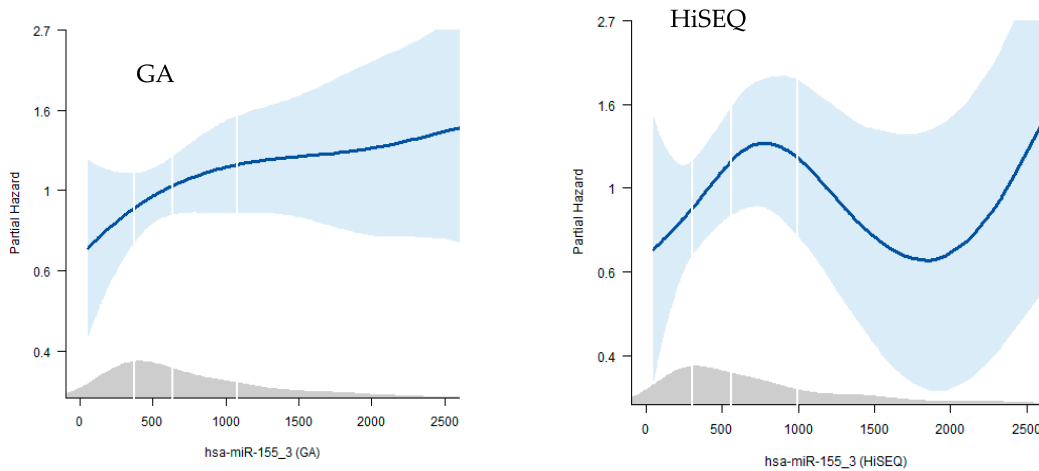
Figure A1. The visual representation of the Cox multivariate analyses, showing the continuous relationship between the expression of mir-155 and risk, adjusted for age, sex, histological grade and cancer stage. The white lines indicate the 1st, 2nd, 3rd and 4th quartile of gene expression. The figure on the left was generated with data from the GA dataset, the figure on the right was generated with data from the HiSeq dataset.